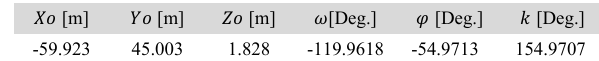
Table 8. Final adjusted pose parameters.